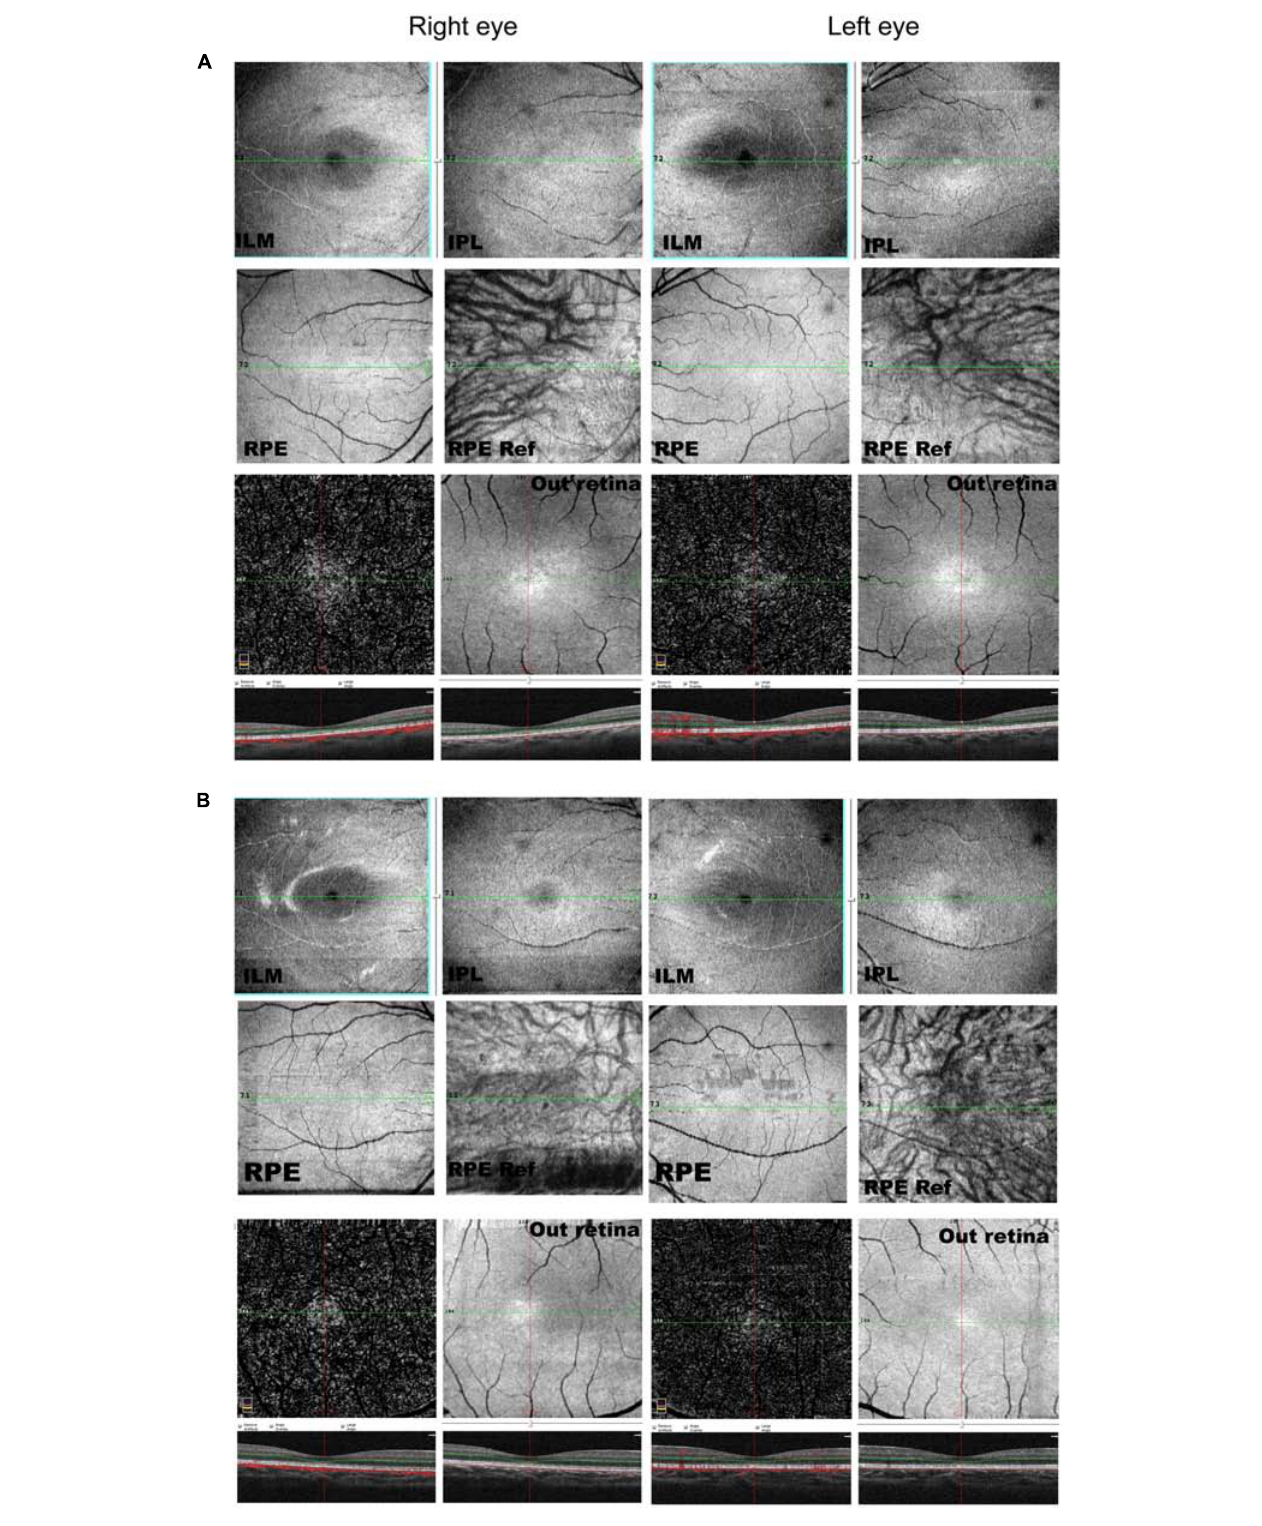
FIGURE 3 | OCTA of P5 (A) and P7 (B) . Data were set to flatten the inner limiting membrane (ILM), inner plexiform layer (IPL), and retinal pigment epithelium (RPE) from the inner to outer retina, and no aberrant vascular networks were detected. ILM, internal limiting membrane; IPL, inner plexiform layer.